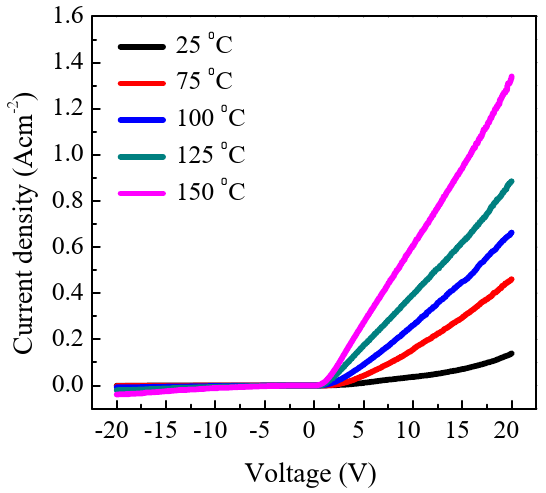
Figure 6. The current density–voltage characteristic of the p -Sb 0.14 GaN/ n -Si heterojunction diode investigated (a) at room temperature and (b) at the different temperature ranges from 25 °C to 150 °C.